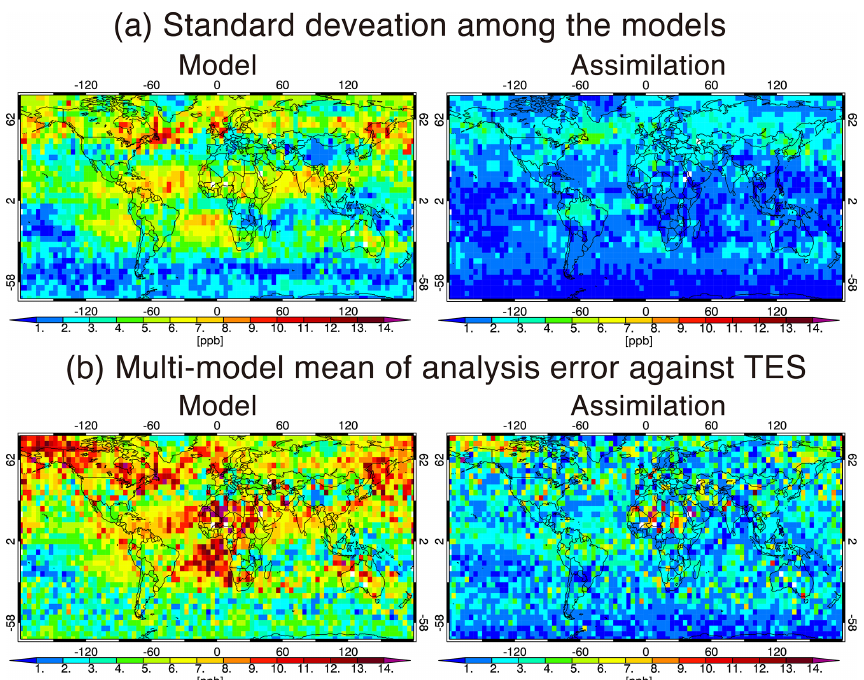
Figure 6. (a) Standard deviation among the models for the data assimilation analysis with application of the TES AK at 510hPa. (b) Spa- tial distributions of multi-model mean (root mean square) values of error against TES measurements for the control runs (left) and data assimilation analyses (right) at